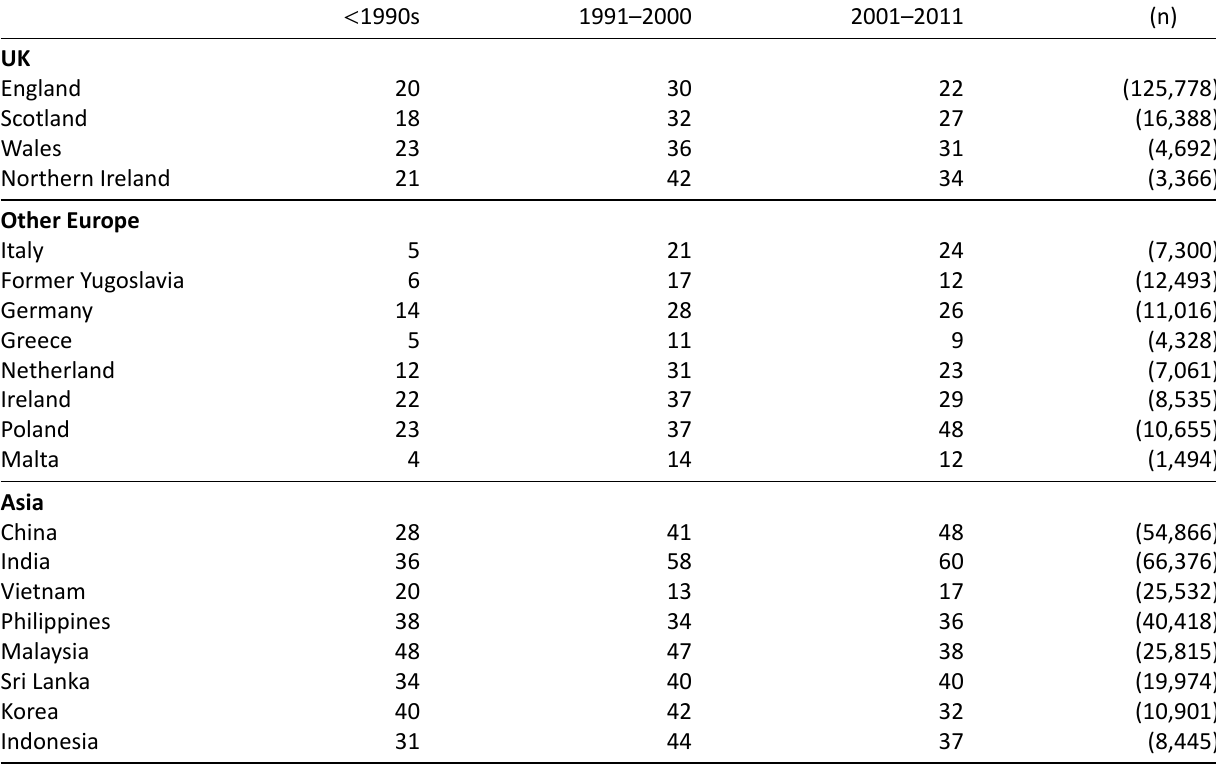
Table 4. Migrants in Australia with a university education, by year of arrival,